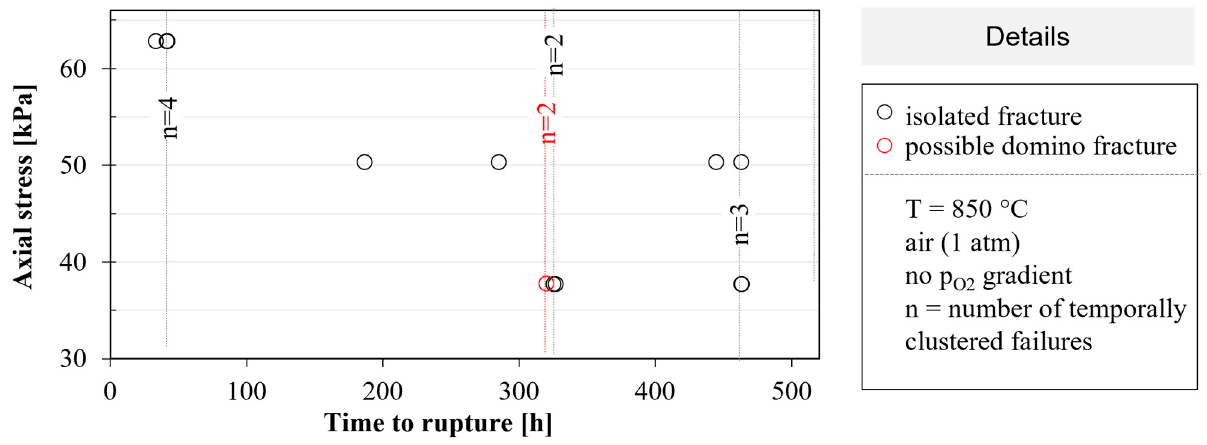
Figure 9. Lifetime of membranes under axial tensile stress; the number n of temporally clustered failures is indicated and marked by dashed lines.